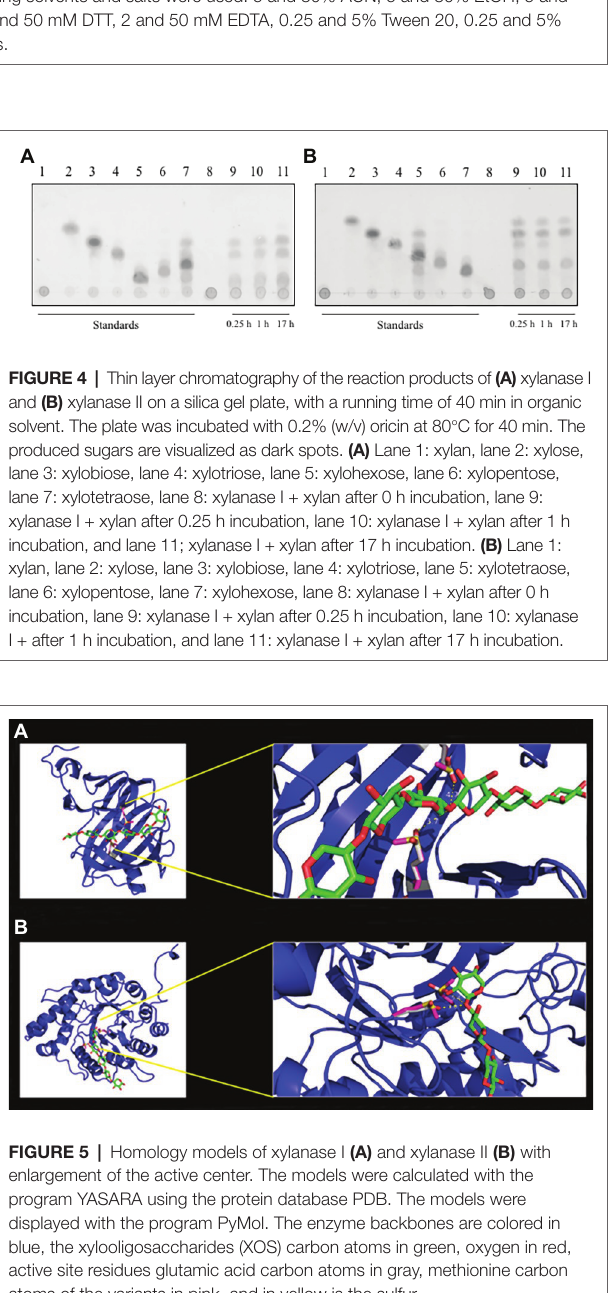
FIGURE 3 | (D) relative activities of xylanase I and xylanase II stored in glycine NaOH buffer pH 9.0 at 4 ° C over a time of 192 h with 0.25 h set to 100%. Relative activity of the xylanase I (E) and xylanase II (F) applying solvents and salts. The following solvents and salts were used: 5 and 30% ACN, 5 and 30% EtOH, 5